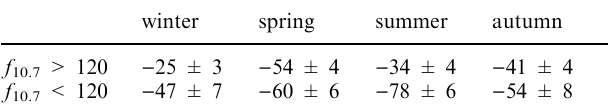
Table 3. Mean winds at 257 km height in m (cid:225) s ) 1